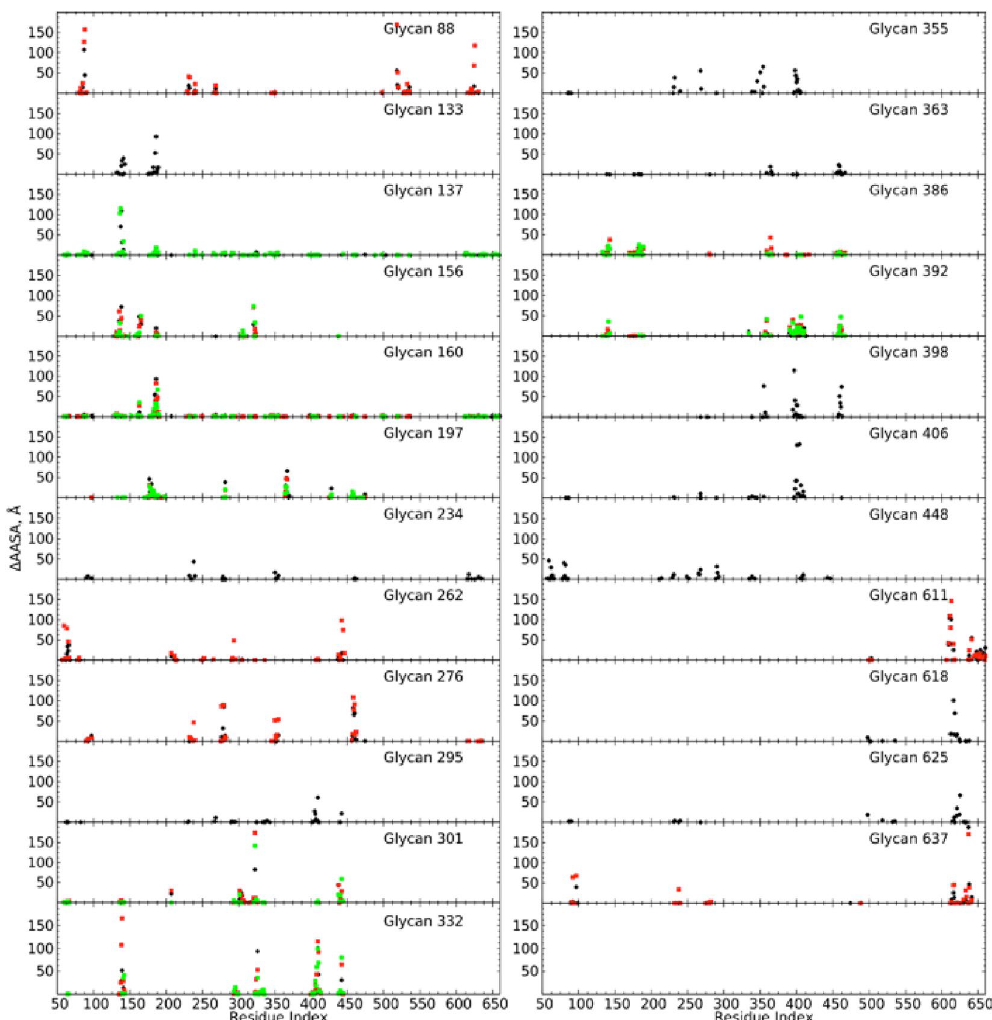
Figure 6. Change in antibody accessible surface area ( Δ AASA, Å 2 ) of all protein residues in the M1 gp120 and gp41 proteins for Monomer 1 (black spheres), Monomer 2 (red spheres) and Monomer 3 (green spheres). Only Δ AASA values greater than 0.1 Å 2 are